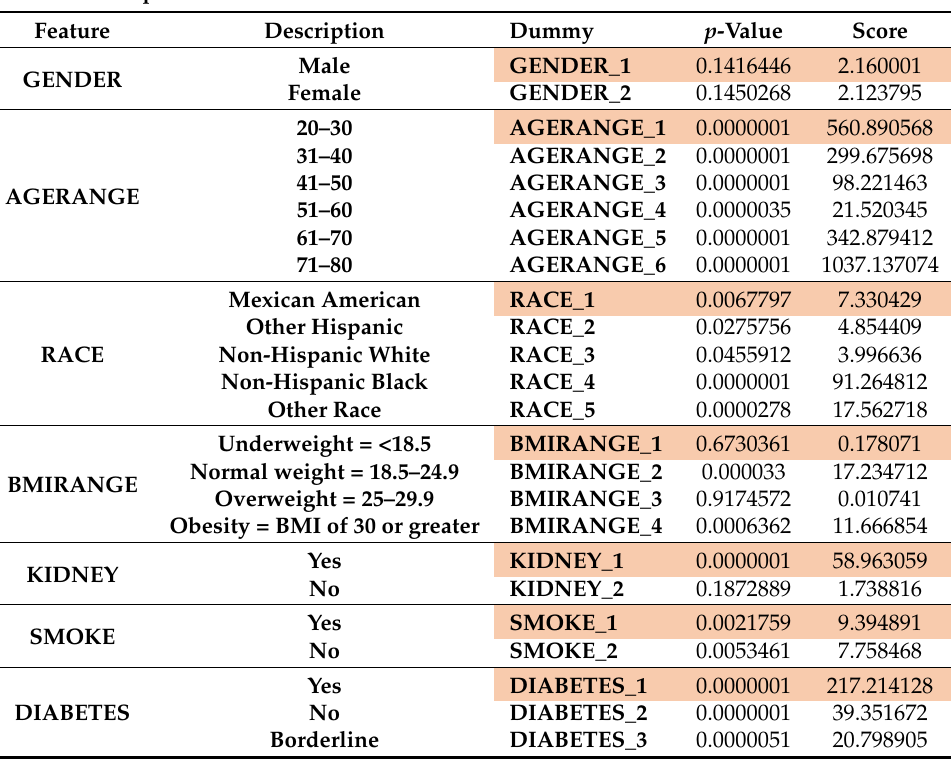
Table 2. Chi2 test and p -value for the independent